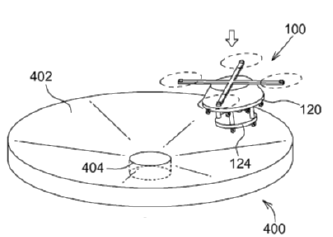
Figure 27. System and method of docking the UAV [78]. 100, UAV; 120, hull edge; 124, ledge; 400, landing platform; 402, landing surface (inclined surface); 404, cavity deepening.